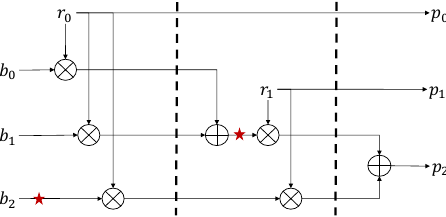
Figure 13: Conversion from Boolean to multiplicative masking with second-order